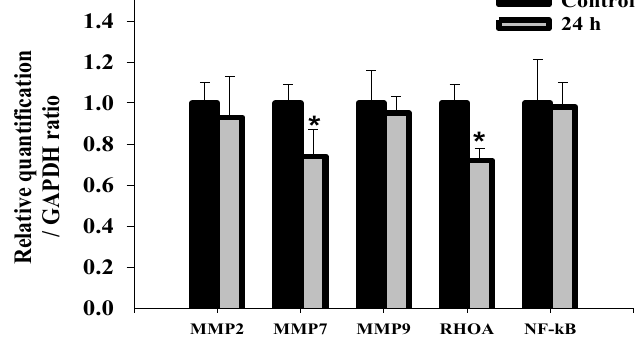
Figure 8. Real-time PCR of MMP-2, -7, and -9, Rho A and NF-κB. U-2 OS cells